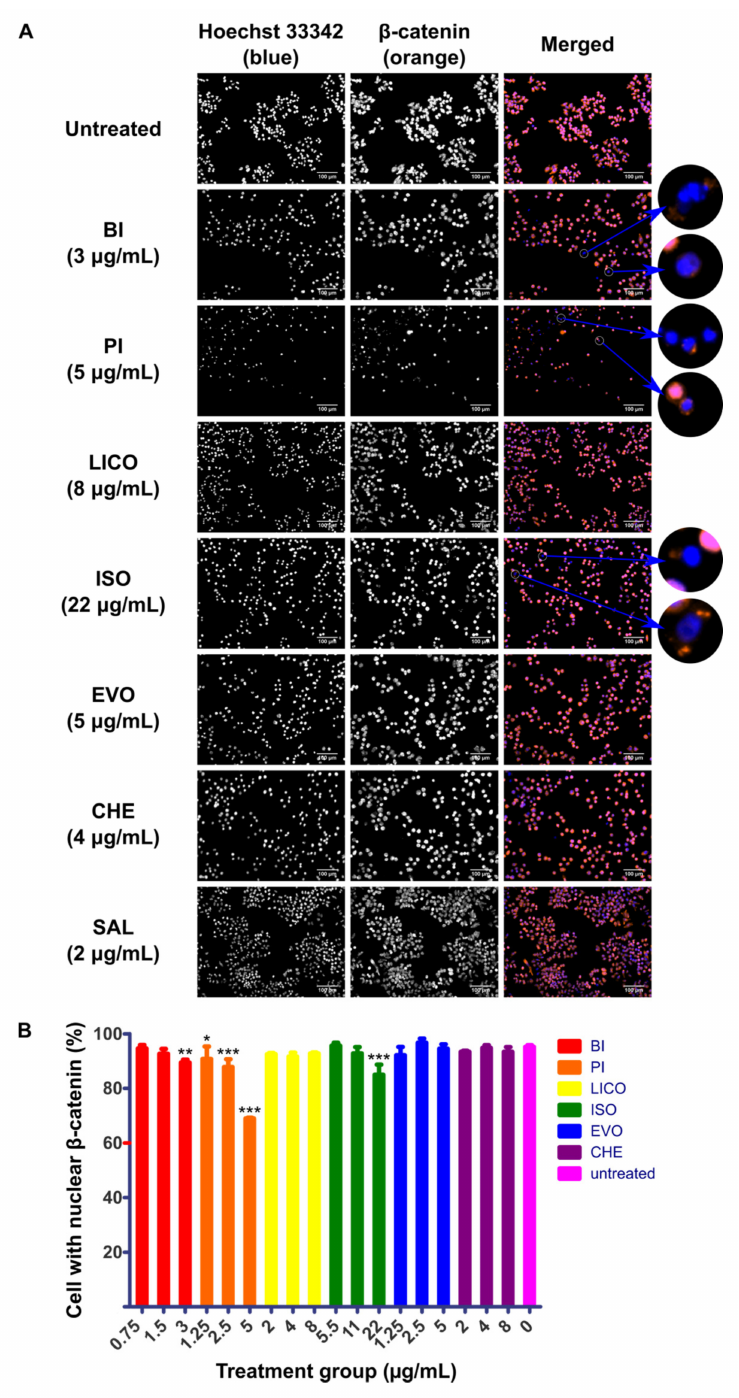
Figure 3. Immunofluorescence detecting localization behavior of β -catenin in phytochemicals-treated HLCSC. HLCSC was pre-treated with GSK3i at 8 µ M for 24 h followed by phytochemicals treatments for 24 h. ( A ) Representative micrographs depicting immunofluorescence staining of β -catenin (orange) counterstained with Hoechst 33342 (blue) to indicate nuclei in phytochemicals-treated HLCSC. White circles highlight cells with diminished β -catenin localization in nucleus. Scale bars represent 100 µ m. ( B ) Graph representing percentage of HLCSC with nuclear β -catenin calculated in response to treatment at 1 IC 50 , 1 IC 50 and IC 50 concentrations of respective phytochemicals. 2 4 The quantification data were derived from a representative immunostaining experiment. Error bars are expressed as mean ± SD from triplicate data in an independent experiment. Statistical significance is expressed as *** p < 0.001; ** p < 0.01; * p <